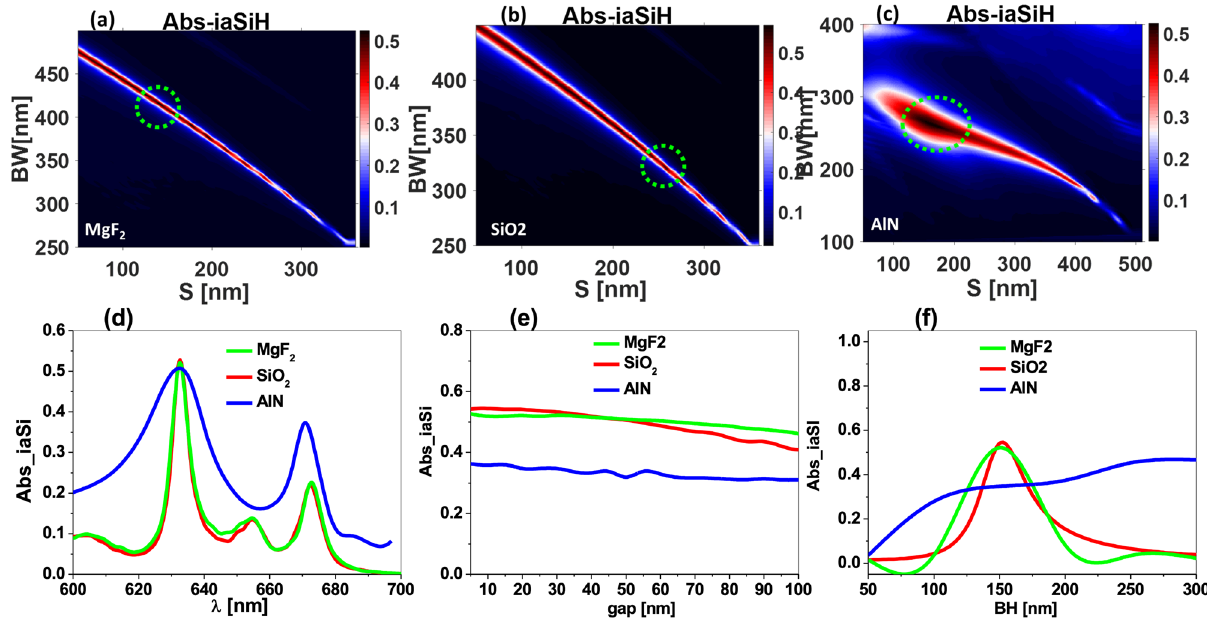
Figure 3. Absorption in the active layer as a function of the BW and S parameters of the bow-tie. The materials of the bow-tie are ( a ) MgF 2 , ( b ) SiO 2 , and ( c ) AlN. The dashed circles represent the location of the maximum absorption at the active layer of the cell. ( d ) Spectral absorption at the active layer for the selected optimized parameters for each material. The role of the gap separation between the triangular portions of the bow-tie, g , is shown in ( e ), and the dependence with respect to the thickness of the dielectric structure, BH , is plotted in ( f ), for the three dielectric materials considered in this analysis. All these calculations have been made at (cid:31) = 632.8 nm (except for subplot d